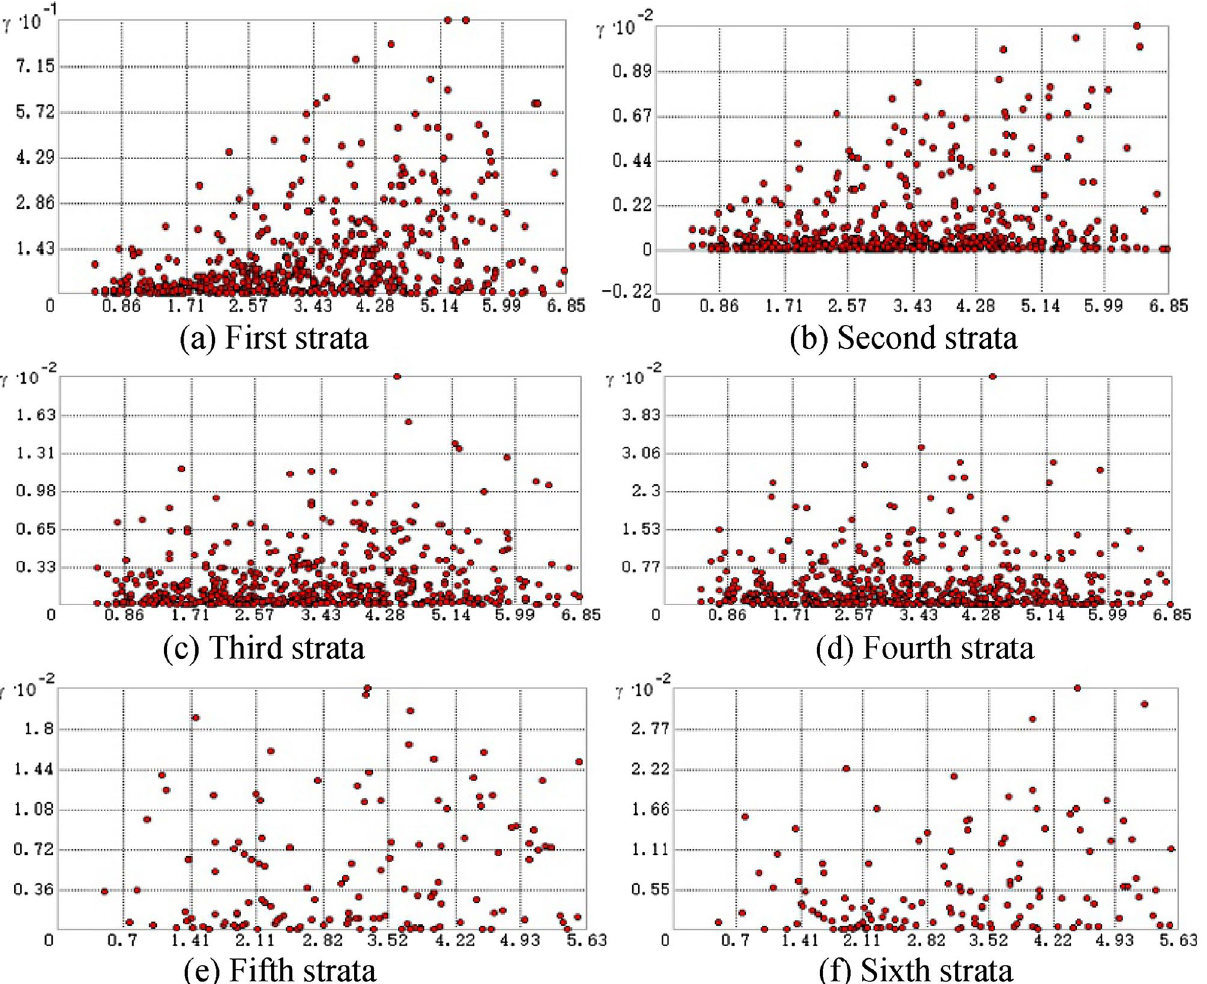
Figure 13. Variation function cloud map of each stratum in which each point represents a data pair, the abscissa represents the distance between the two points, and the ordinate represents the variation function value. The first layer and the second layer show that as the distance of the sample points increases, the value of the variation function increases gradually, and the point cloud increases gradually, which accords with the characteristics of spatial autocorrelation. The cloud images of the other four strata are scattered and have no obvious trend, indicating that they do not have the property of spatial